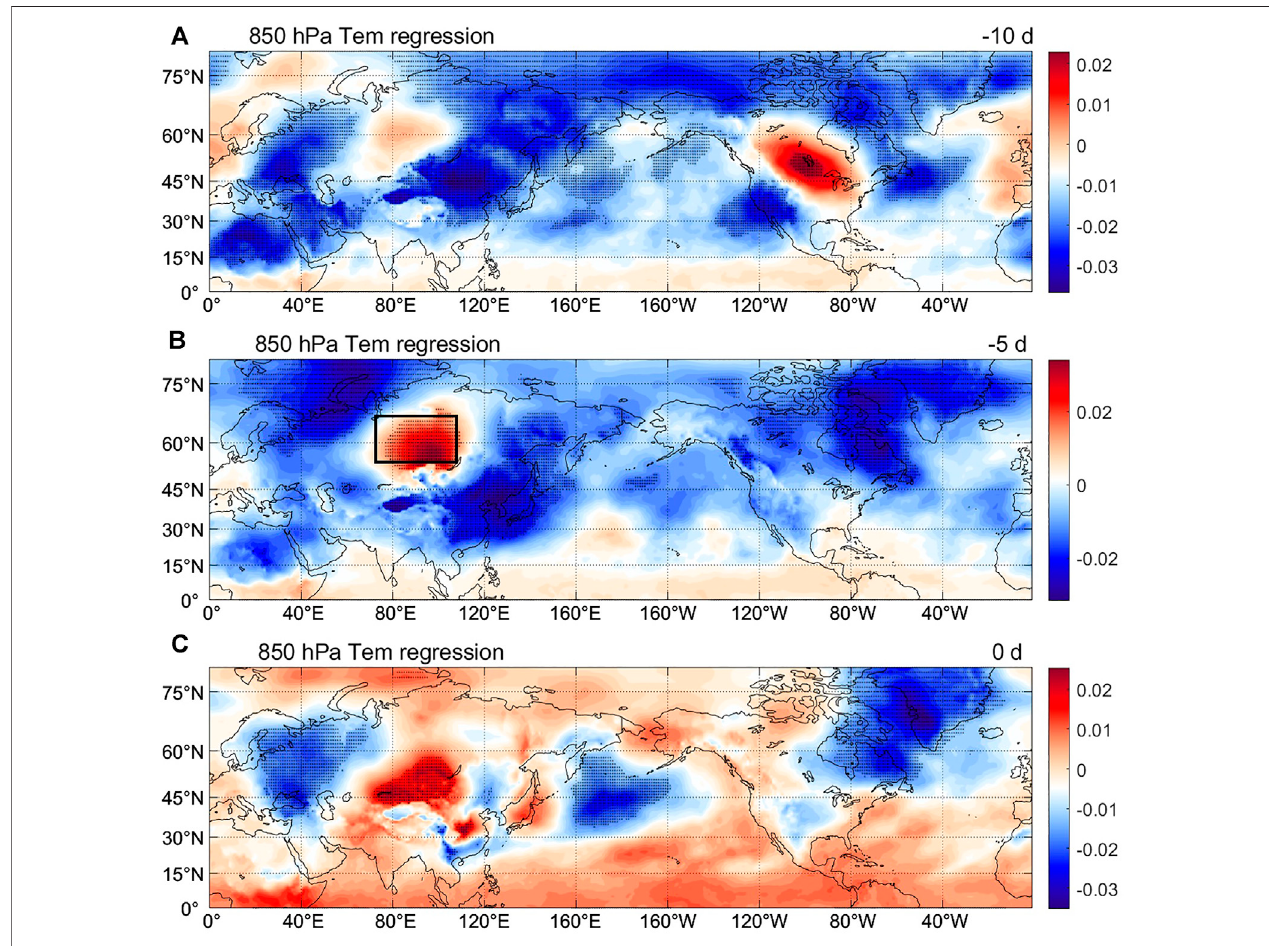
FIGURE 4 | Lead regression analysis of PM 2.5 concentration on the 850 hPa temperature fi eld (A) ten days before, (B) fi ve days before, and (C) day of.